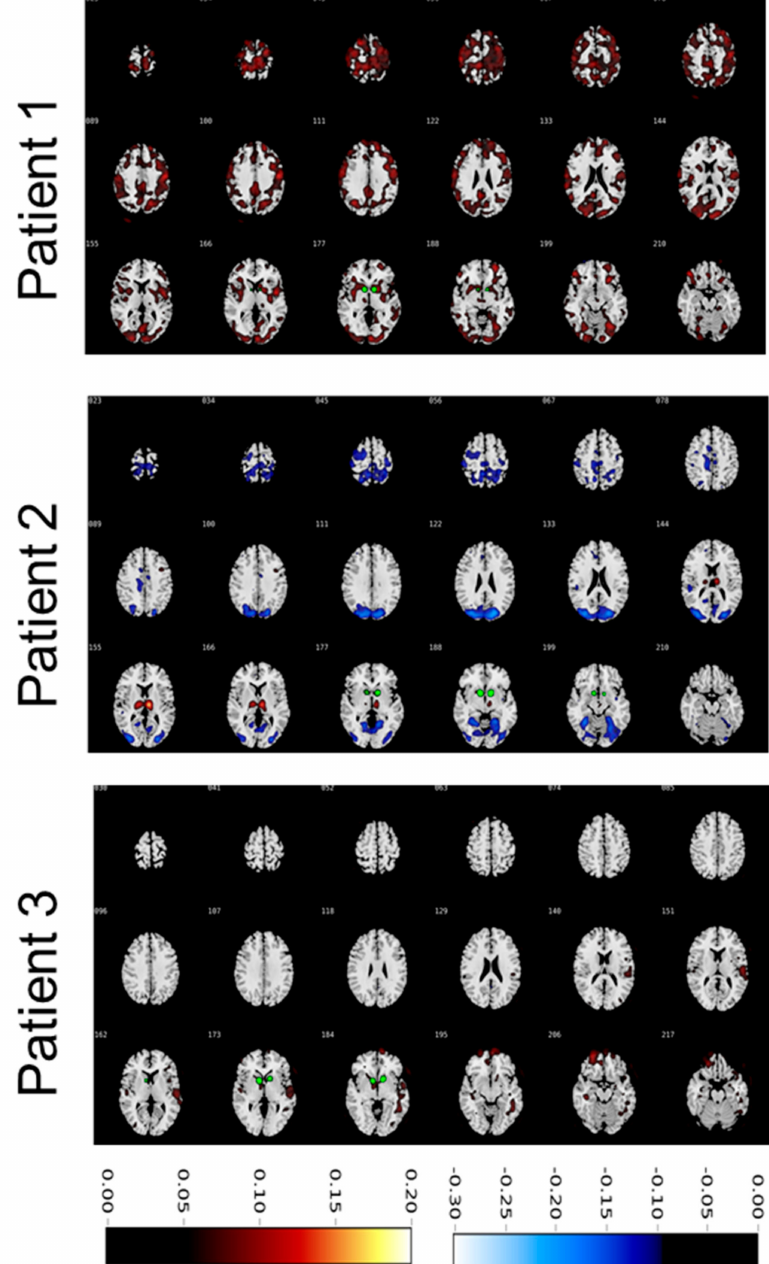
Figure 3. Ratios of glucose metabolism in deep brain stimulation ON vs. OFF condition. Warm colours indicate increased uptake in ON condition compared to OFF condition. Cold colours indicate increased metabolism in OFF condition compared to ON condition. Colour bars represent ratios in standardized uptake values. Volumes of activated tissue are displayed in